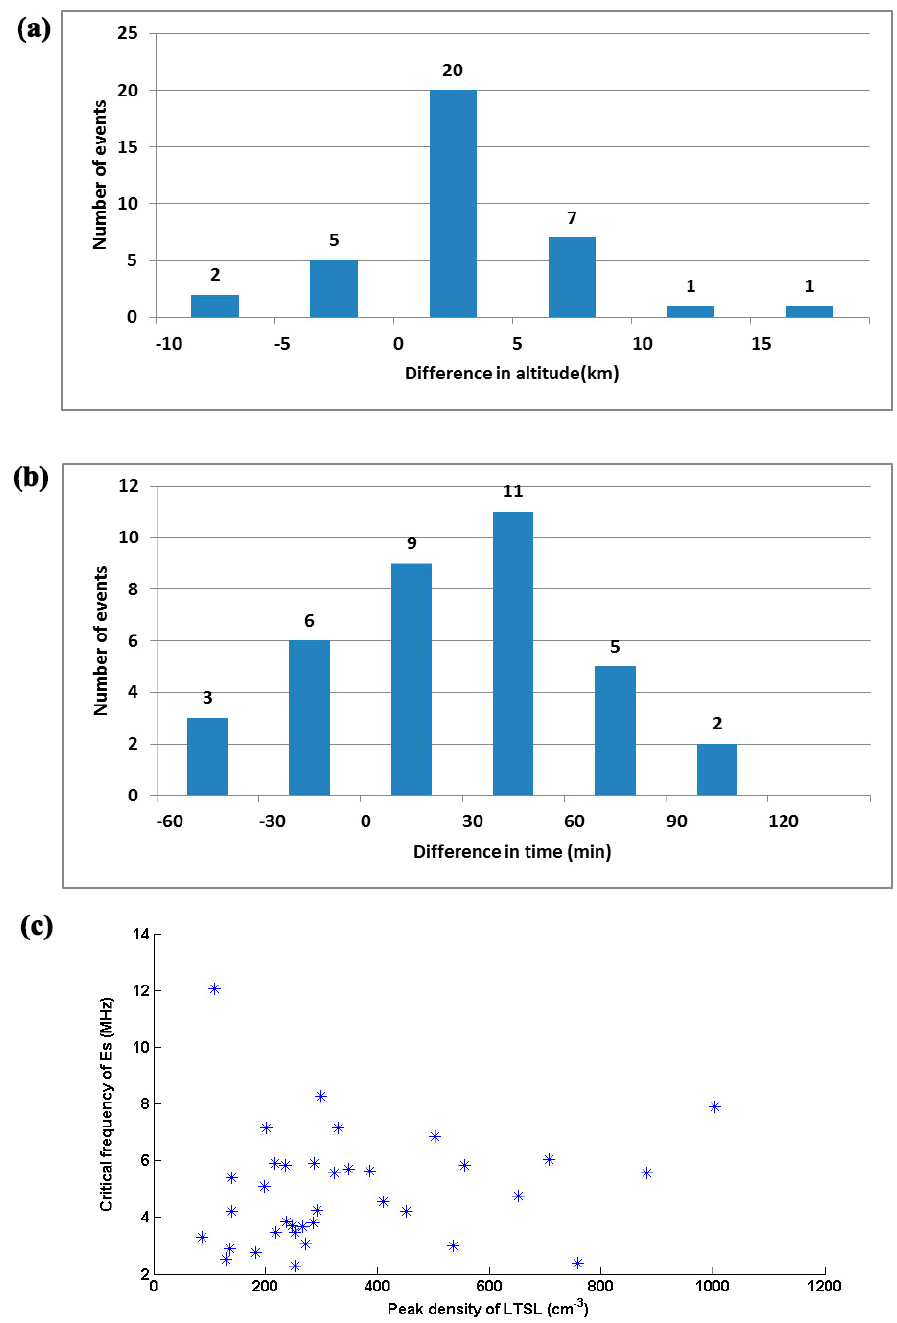
Figure 7. ( a ) The altitude of Es versus LTSL (positive number indicates that Es higher than LTSL), ( b ) the local time of the Es versus LTSL (positive number indicates that Es occurred earlier than LTSL) and ( c ) the intensity of the Es versus LTSL.